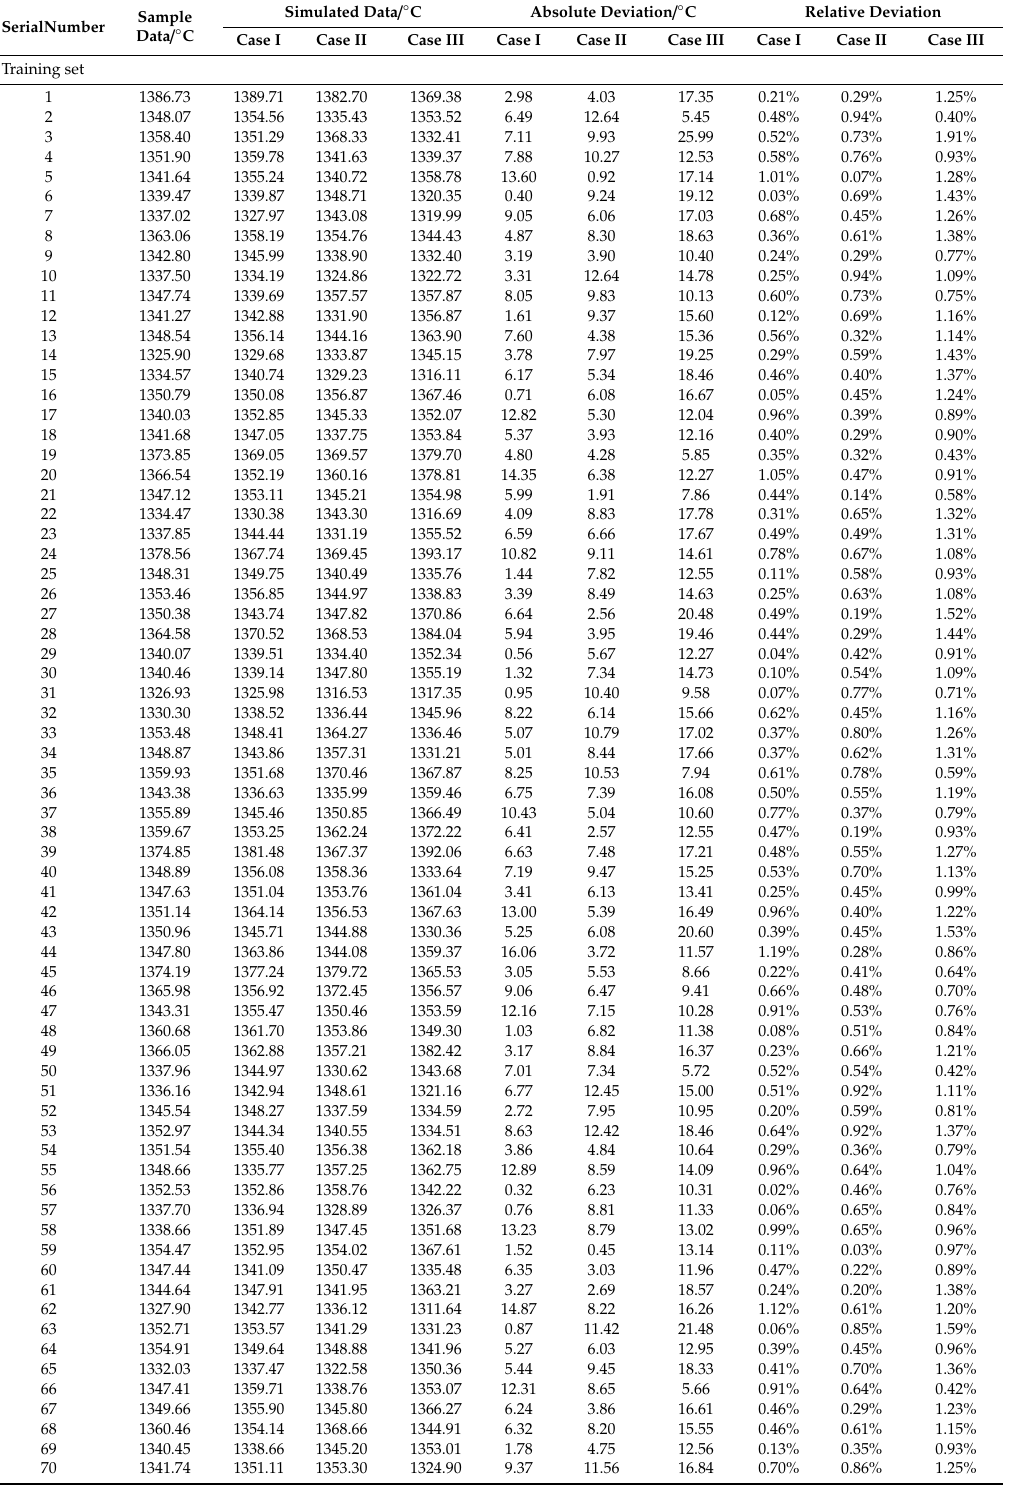
Table A1. Simulation data and sample data deviation in three cases (the sample data of coal is from Hebi lean